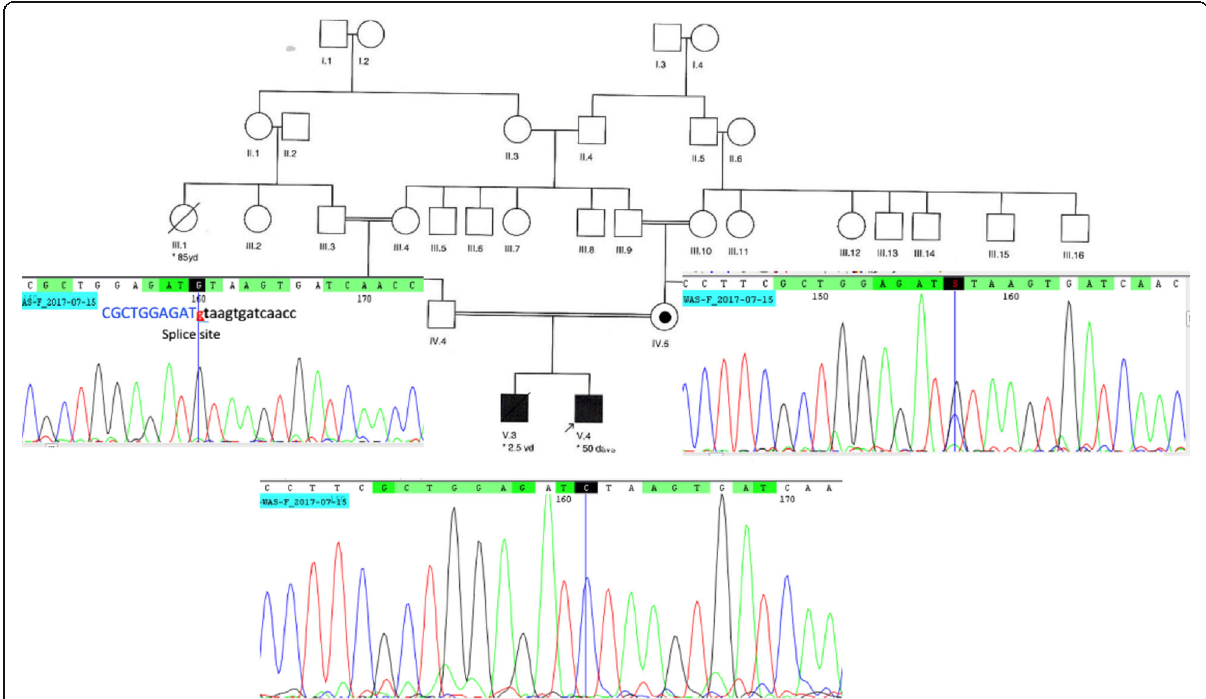
Fig. 2 Sanger sequencing chromatogram. The proband showed hemizygous c.360 + 1G > C (C/C), his mother as heterozygous (G/C), and his father as normal